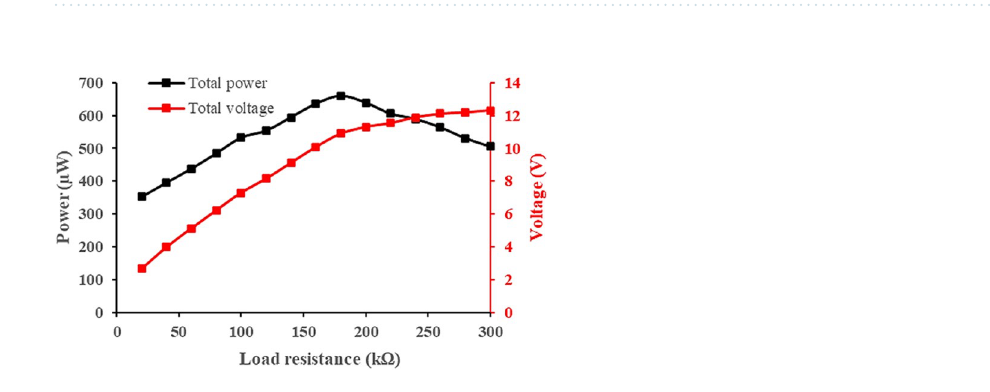
Figure 13. Total power and voltage output of MT-HPTEH against load resistances.